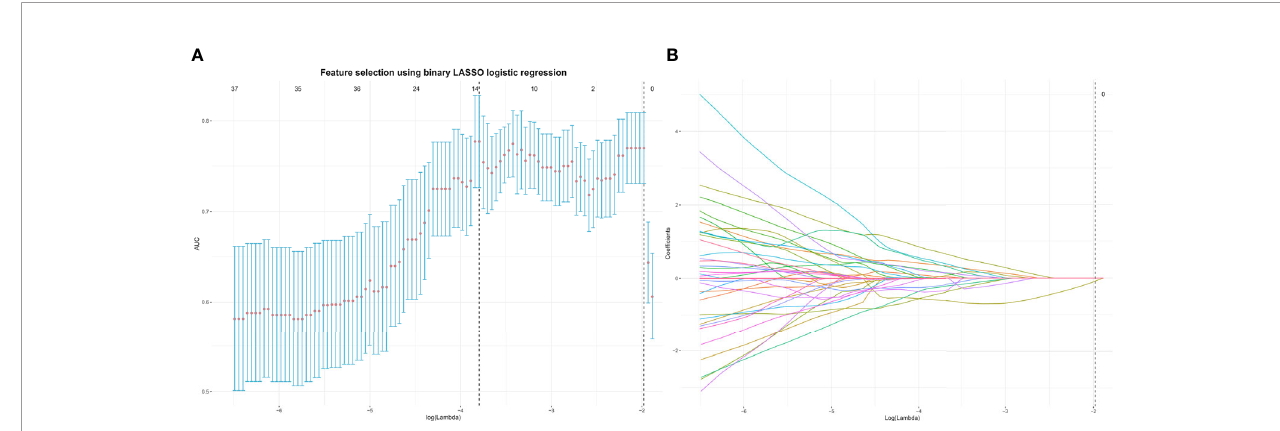
FIGURE 2 | The top 13 radiomics features associated with DMI in G 1/2-EEC patients younger than 45 years were identi fi ed using the least absolute shrinkage and selection operator (LASSO) method in the primary group. (A) The parameter lambda ( l ) is chosen using 10-fold cross-validation. (B) LASSO coef fi cient pro fi les of the selected features. A vertical line is plotted at the optimal value, resulting in 13 features with nonzero coef fi cients. EEC, endometrioid adenocarcinoma; DMI, deep myometrial